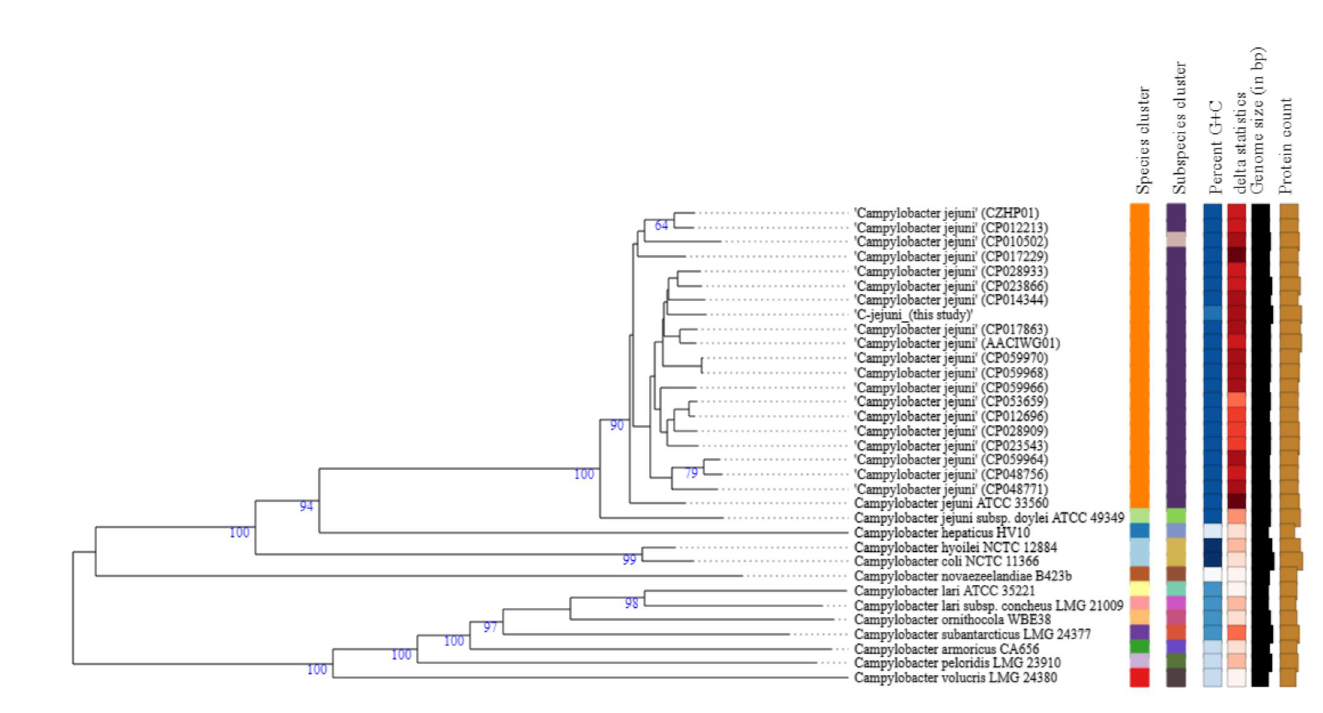
Figure 1. Type (Strain) Genome Server (TYGS) result for C. jejuni strain 200605 dataset. Tree inferred with FastME 2.1.4 [42] from GBDP distances calculated from genome sequences. Branch lengths are scaled in terms of GBDP distance formula d 5 ; numbers above branches are GBDP pseudo-bootstrap support values from 100 replications. Percent G+C (27.39–30.98); δ statistics (0.138–0.286); protein content